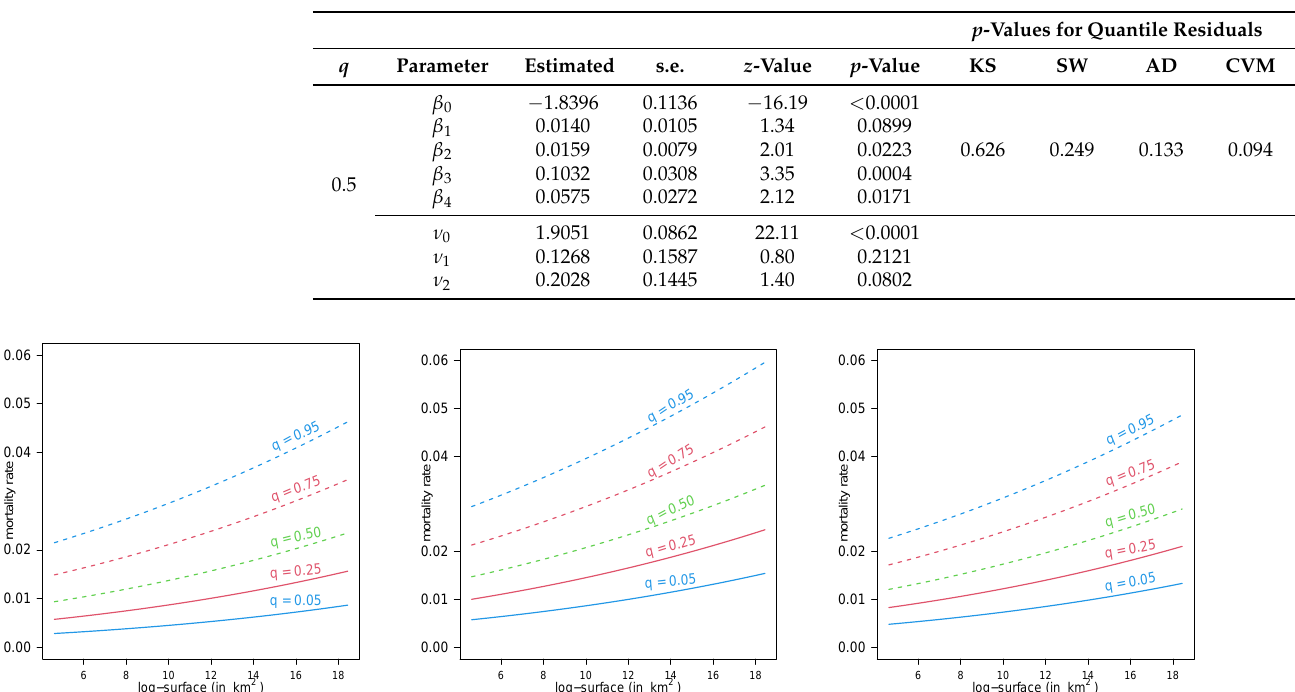
Figure 4. The estimated 100 × q th quantile in the RPGJSB2 q model for log ( population ) = 16 (around 9 million people) varying the log ( surface ) for countries in Africa, Asia, or Oceania ( left panel), the Americas ( center panel), and Europe ( right panel) considering the cloglog link and G the cdf from the logistic